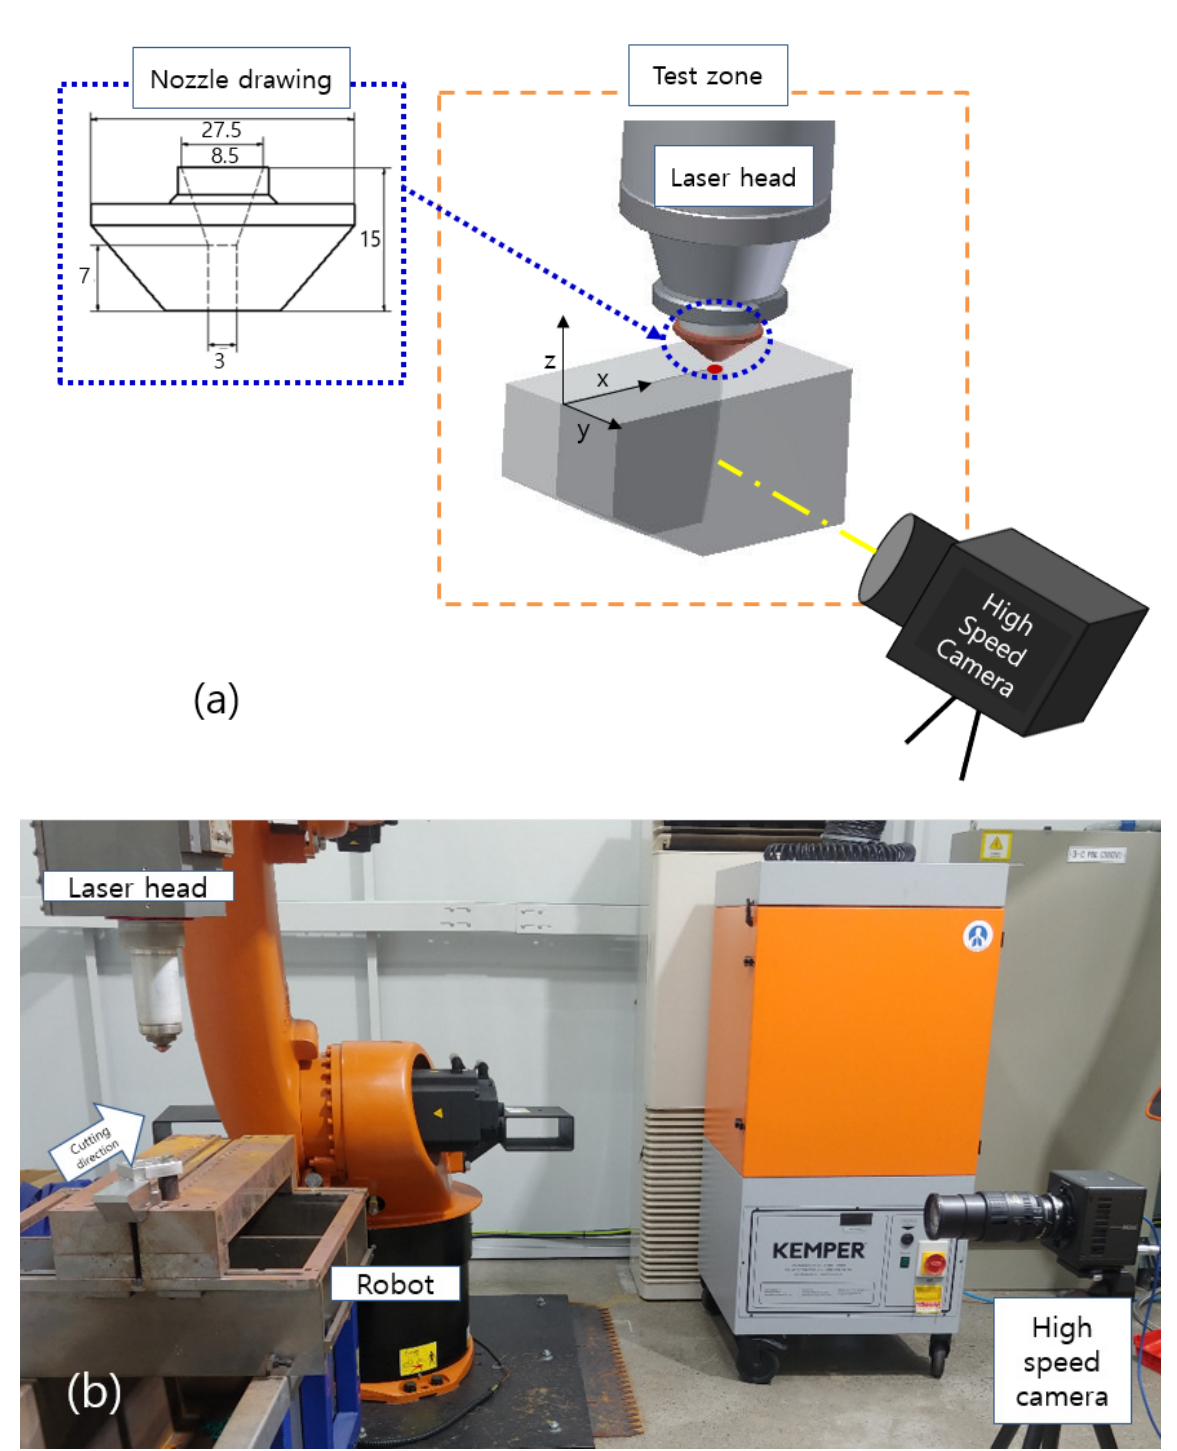
Figure 2. Experimental setup: ( a ) Schematic and ( b ) laser cutting experimental set-up.